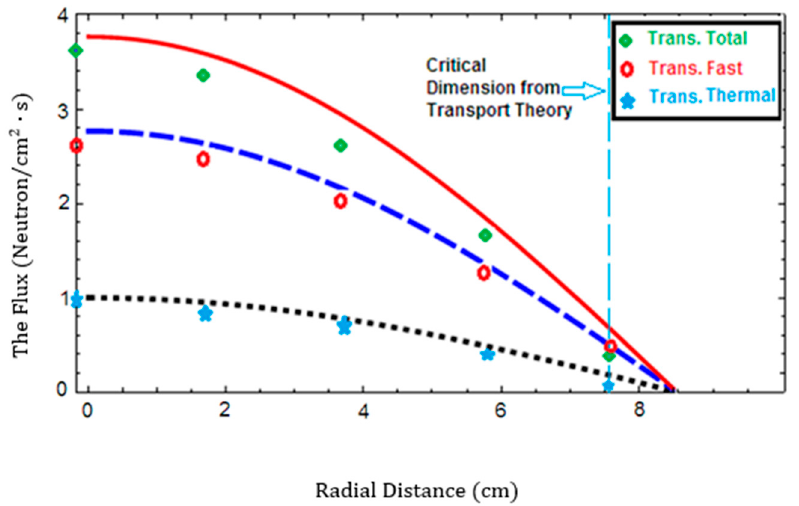
Figure 3. Two Energy Groups fluxes for an infinite Slab of 93% enriched U. Dotted line: Thermal flux, Dashed line: Fast flux, Solid line: Total fluxes.